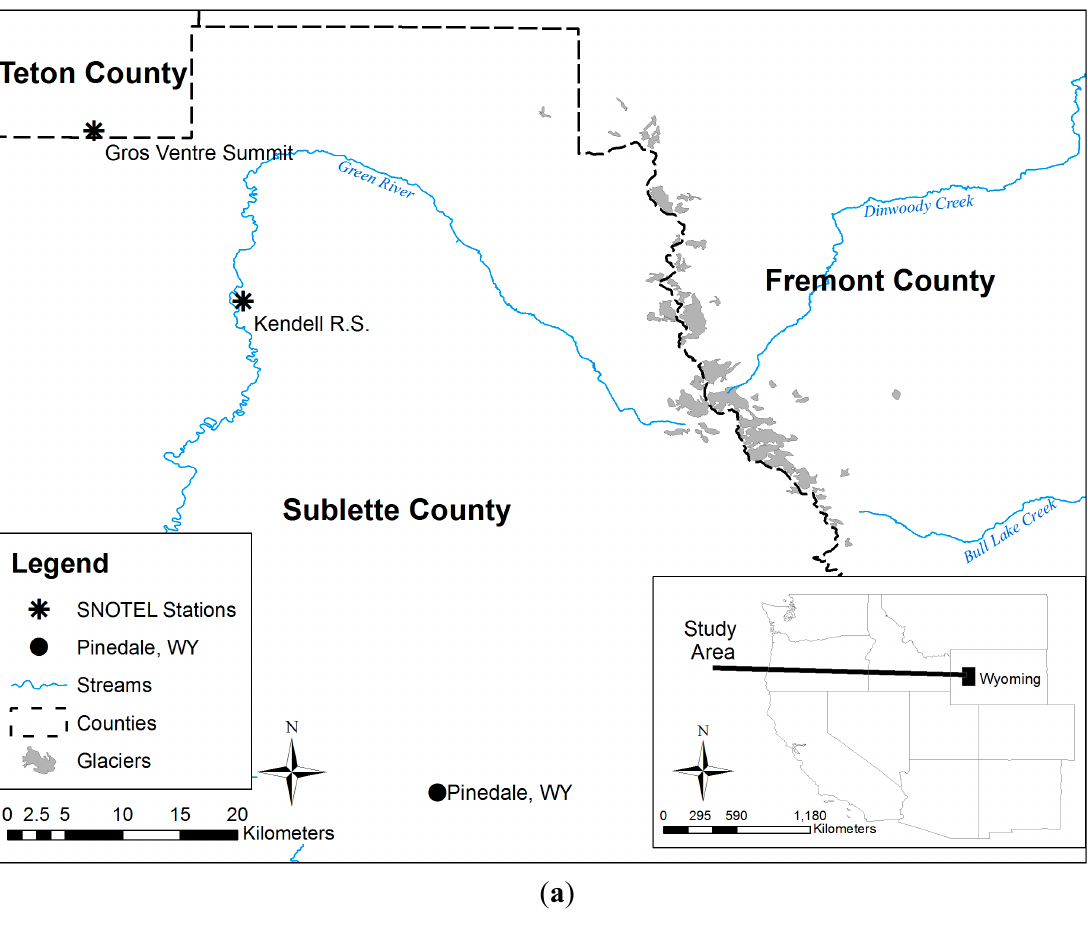
Figure 1. ( a ) Study area of Wind River Range, Wyoming, USA and SNOwpack TELemetry (SNOTEL) Station Sites. ( b ) Location map of 44 glaciers in the Wind River